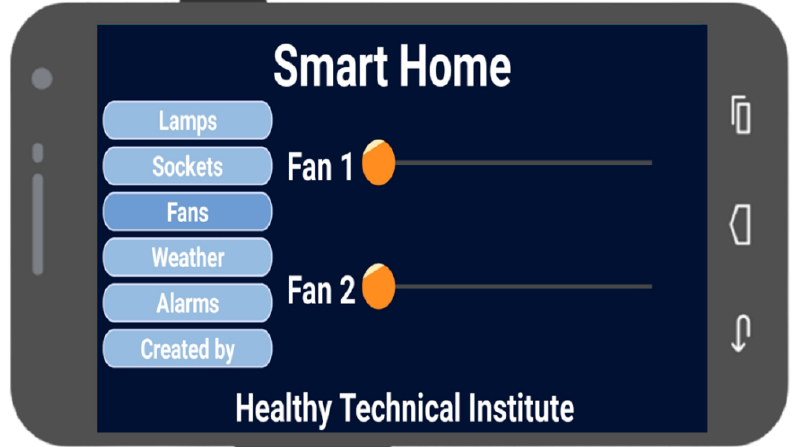
Figure 6. The graphical user interface used to control the speed of the fans.